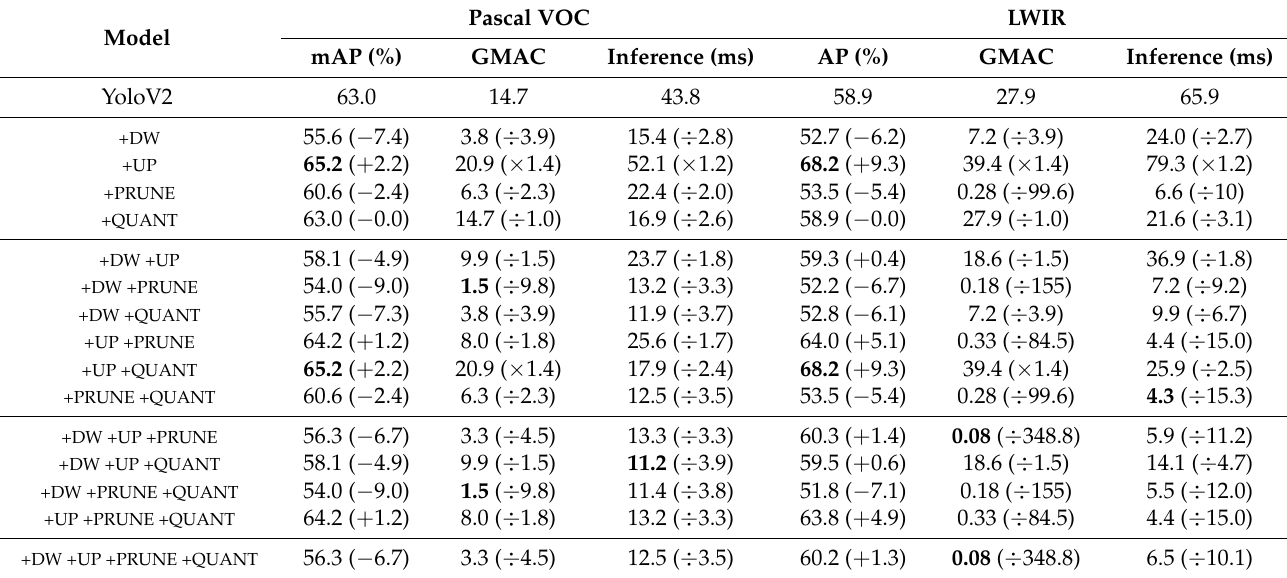
Table 9. Ablation study of the different optimization methods, evaluated on both the Pascal VOC and LWIR test dataset. Note that the inference time is not including the post-processing. The best values are shown in bold. Pascal VOC LWIR Model mAP (%) GMAC Inference (ms) AP (%) GMAC Inference (ms) YoloV2